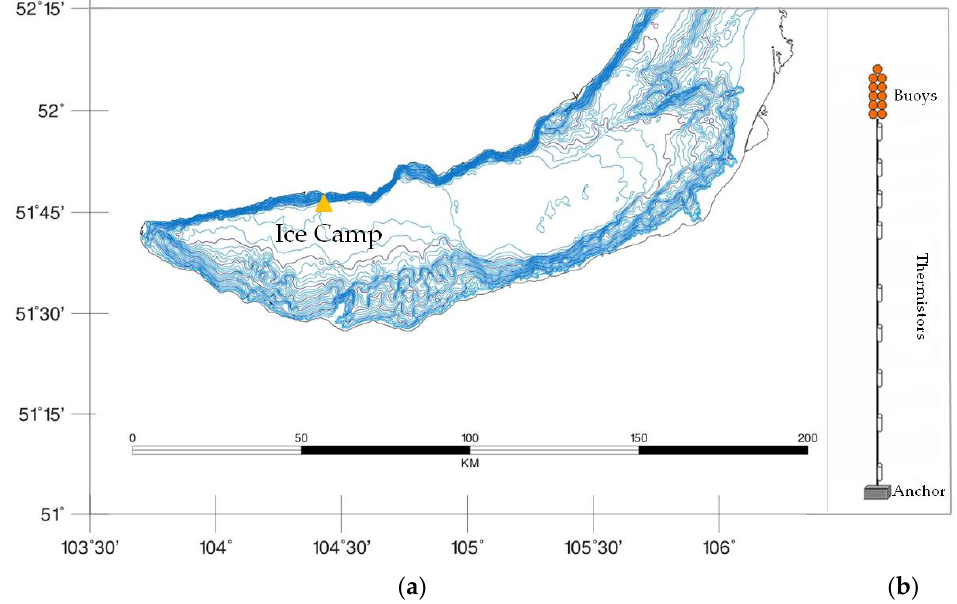
Figure 1. Isobath map in the southern basin of Lake Baikal [37,38], the location of buoy station Ice Camp (orange triangle) near Ivanovskiy Cape ( a ) and a scheme of the buoy station ( b ).